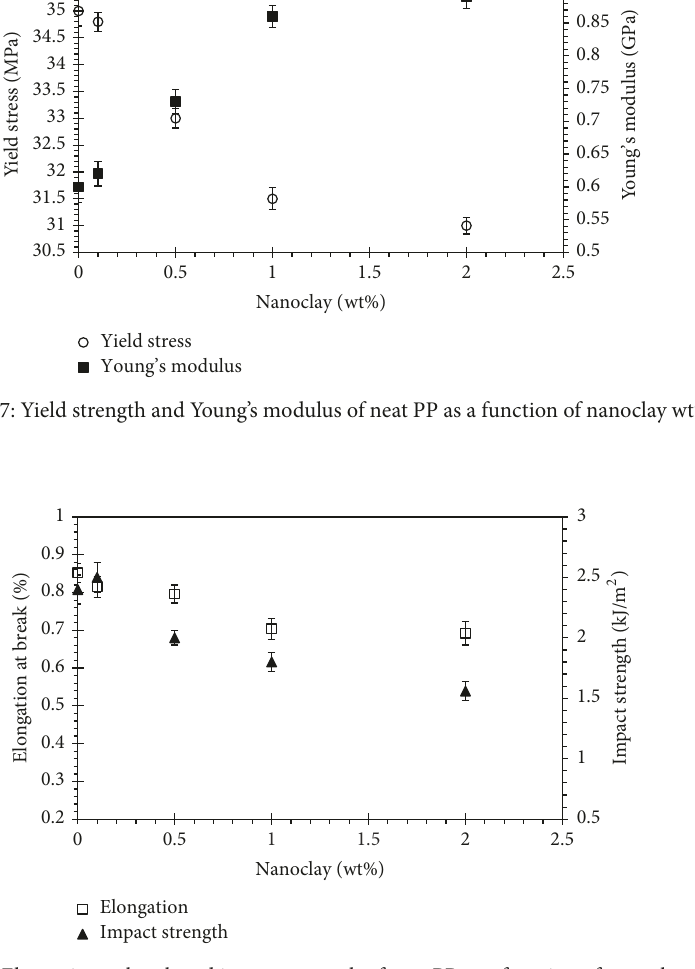
Figure 8: Elongation at break and impact strength of neat PP as a function of nanoclay wt%.